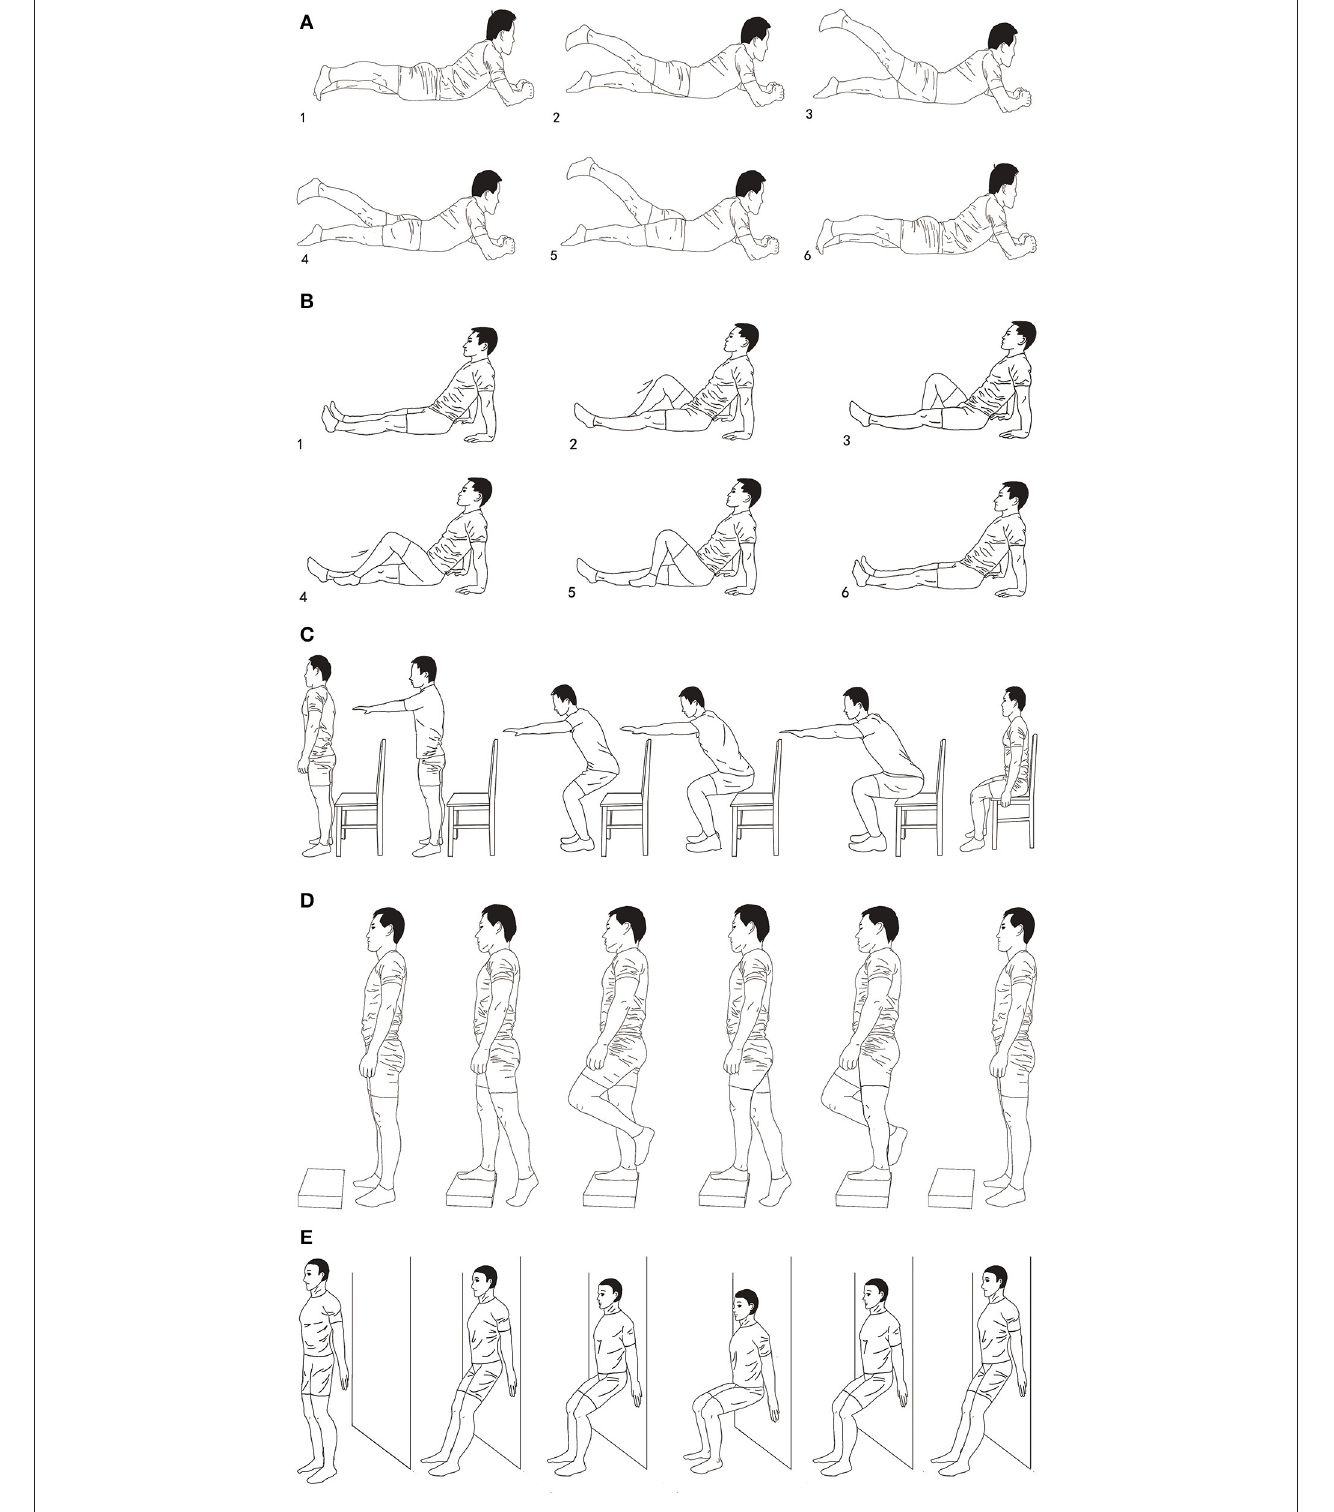
FIGURE 2 | Demonstration of stretching training exercise (STE). The figure mainly described the stretching exercise flow of knee joint flexion and extension in different postures. (A) Lower limb flexion and extension in supine position, (B) lower limb flexion and extension in prone position, (C) sit and stand test training, (D) alternating one-legged stair support tasks, (E) static squatting training against the wall.